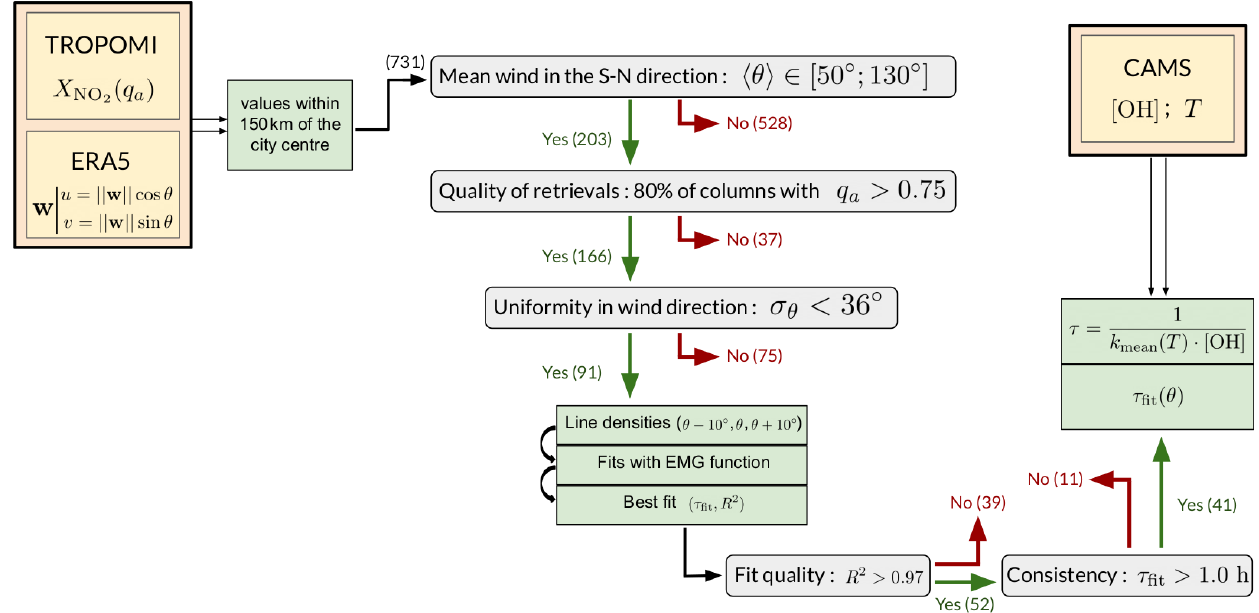
Figure 4. Selection method for NO 2 patterns over Riyadh. Datasets (yellow-orange) are used to calculate the quantities (light green) that are submitted to different tests (grey). A total of 731 patterns are progressively conserved (green arrows) or rejected (red arrows). At each stage, the number of conserved or rejected patterns are noted within brackets (the value is only given for calculations performed at level B ). This selection process compares the lifetimes estimated by the EMG function fitting with TROPOMI line density profiles to the lifetimes calculated according to Eq. (2) with CAMS